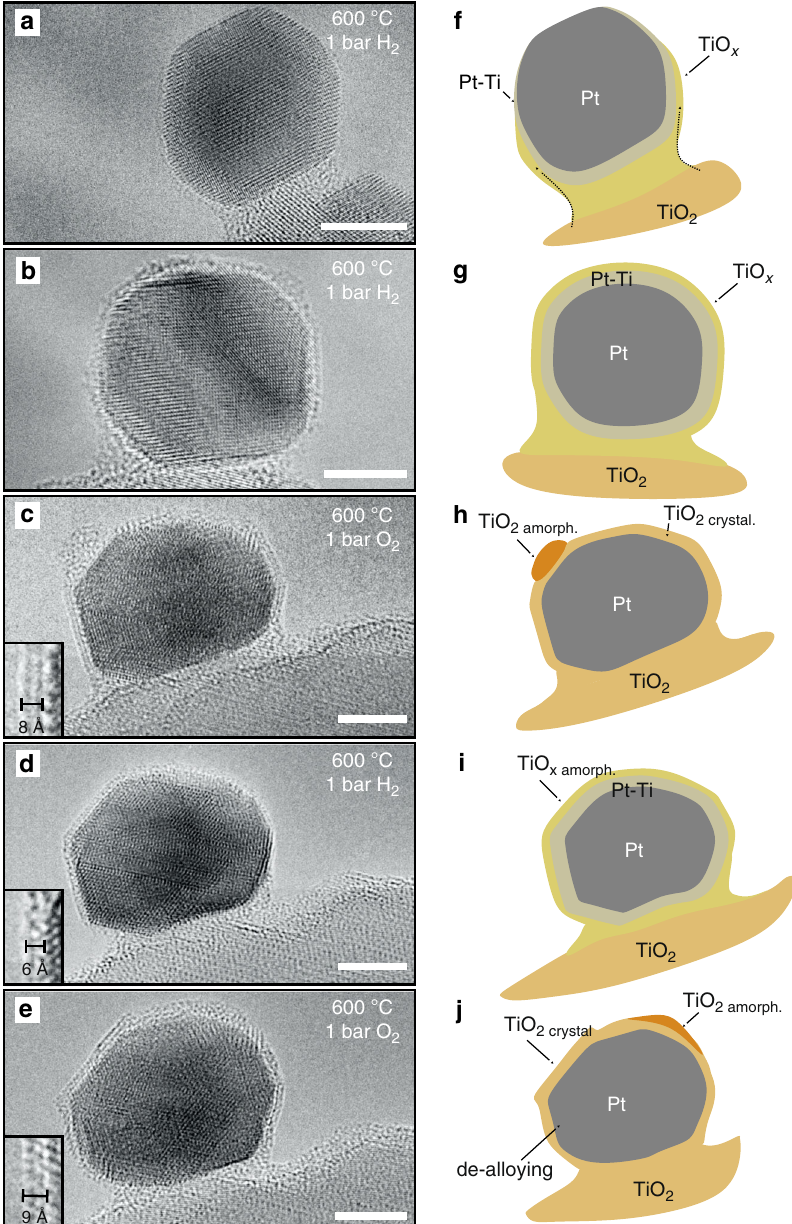
Fig. 1 Evolution and dynamic structural changes of the overlayer in SMSI. A platinum particle on a titania support in the fi rst exposure to H 2 at 600 °C ( a , b ) and the subsequent atmosphere change to O 2 at 600 °C ( c ), a switch to H 2 ( d ) and then a switch to O 2 again ( e ), and interpretation of the phenomena based on the combined results of in situ transmission electron microscopy, in situ X-ray photoemission spectroscopy, and in situ powder X-ray diffraction ( f – j ). Insets for c – e show a magni fi ed image of the overlayer structure observed. Scale bar is 5